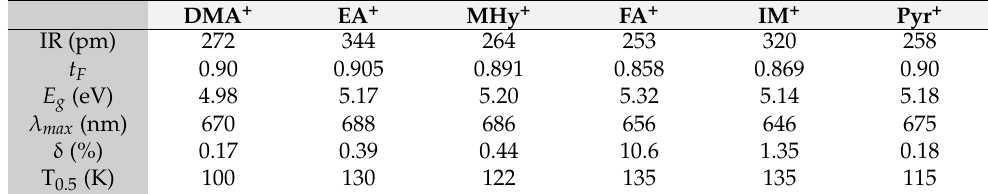
Figure 4. ( a ) Low-temperature PL spectra of [A]Mn(H 2 POO) 3 ; ( b ) energy-level diagram of Mn 2+ ions; ( c ) CIE coordinates of the investigated samples. Table 1. List of the most important parameters of [A]Mn(H 2 POO) 3 perovskites, such as ionic radius (IR) of the ammonium cations [41], tolerance factor ( t F ), energy band gap ( E g ) [36 – 38], the position of the PL band at 80 K ( λ max ), octahedral deviation (δ) from the perfect shape [36 – 38], and quenching temperature (T 0.5 ) .